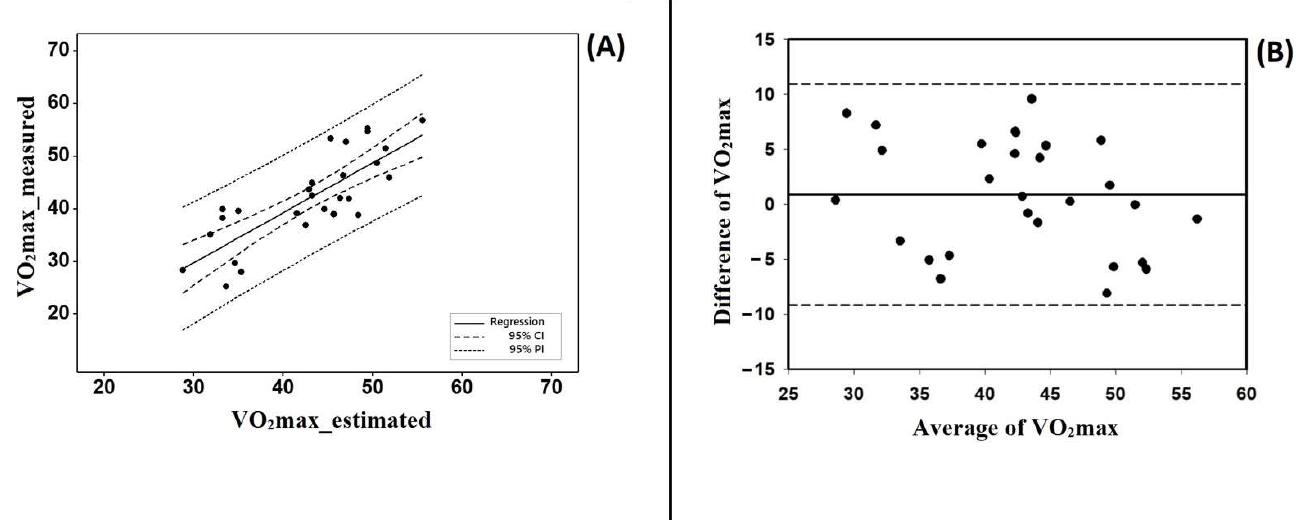
Figure 1. Linear regression between VO 2max measured and estimated by equation 1 (panel ( A )), and Bland–Altman plots (panel ( B )). All plots were within 95CI. This data refers to the validation group.